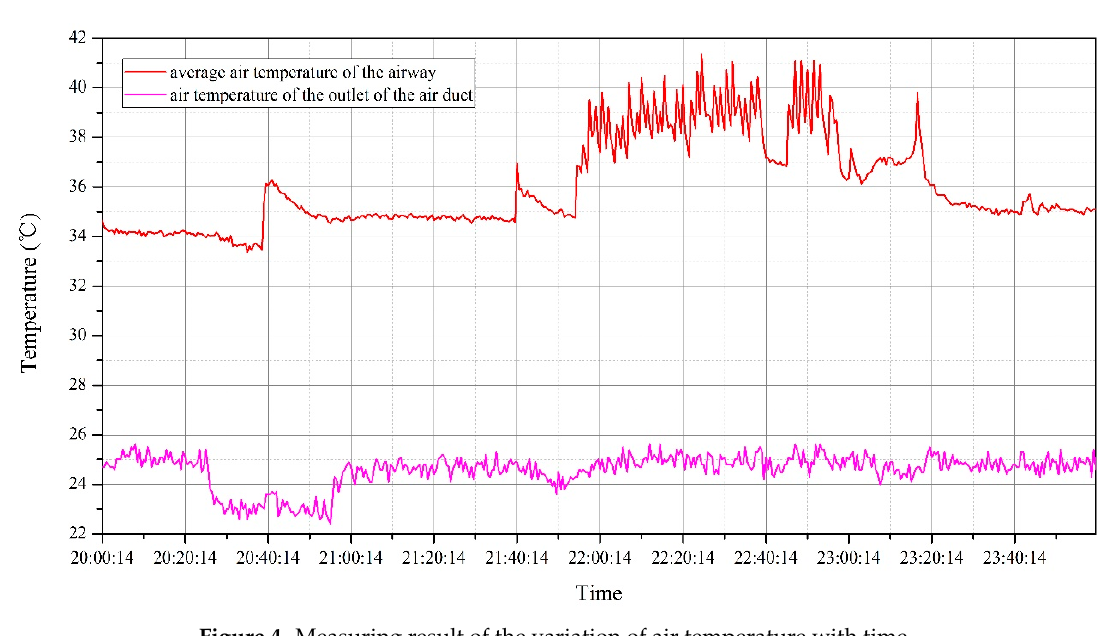
Figure 4. Measuring result of the variation of air temperature with time. Table 1. Mining process record.